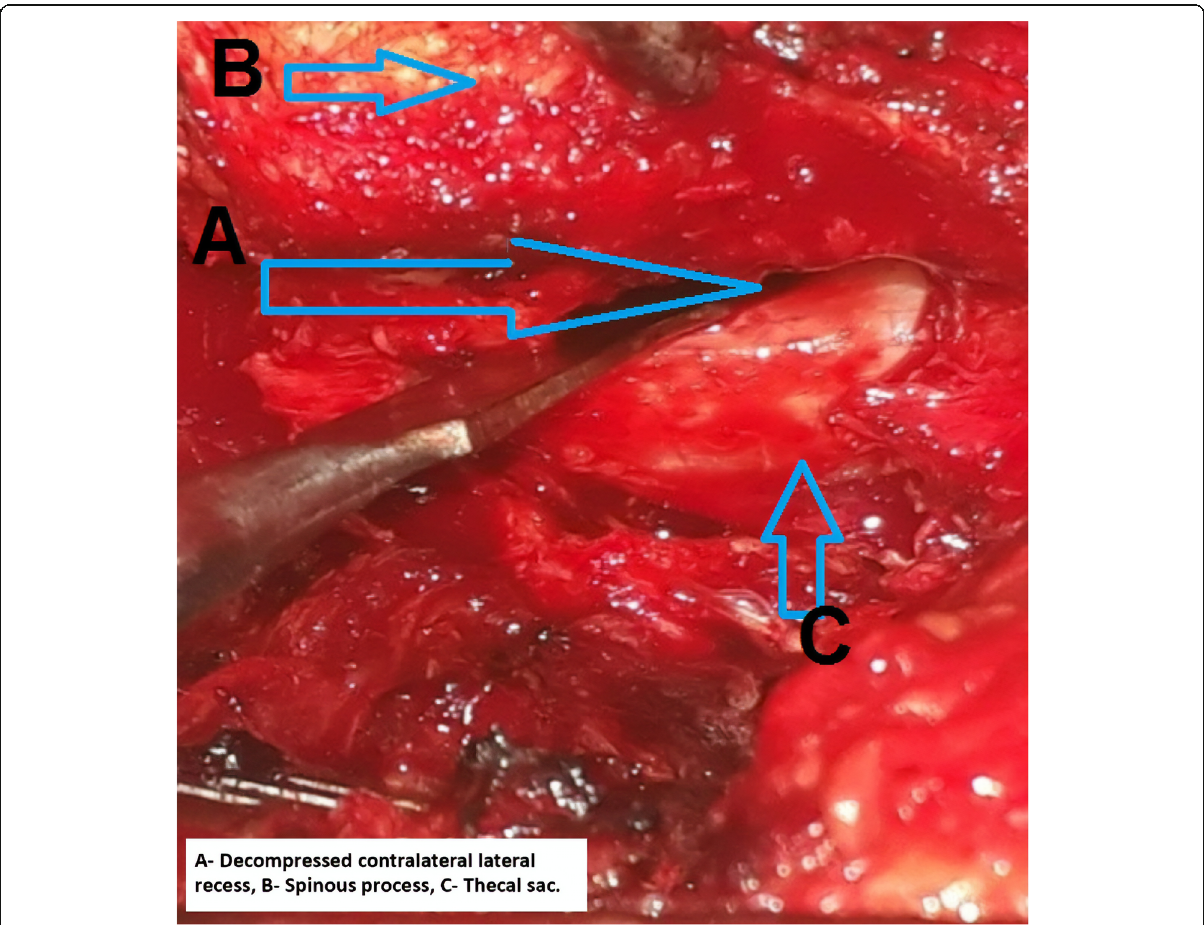
Fig. 1 Intraoperative image showing the unilateral laminotomy and bilateral decompression